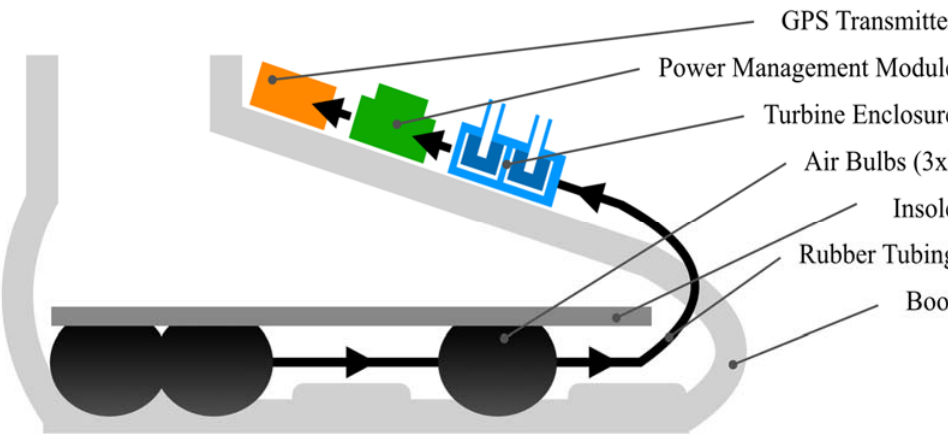
Figure 1. Schematic of energy harvesting system.